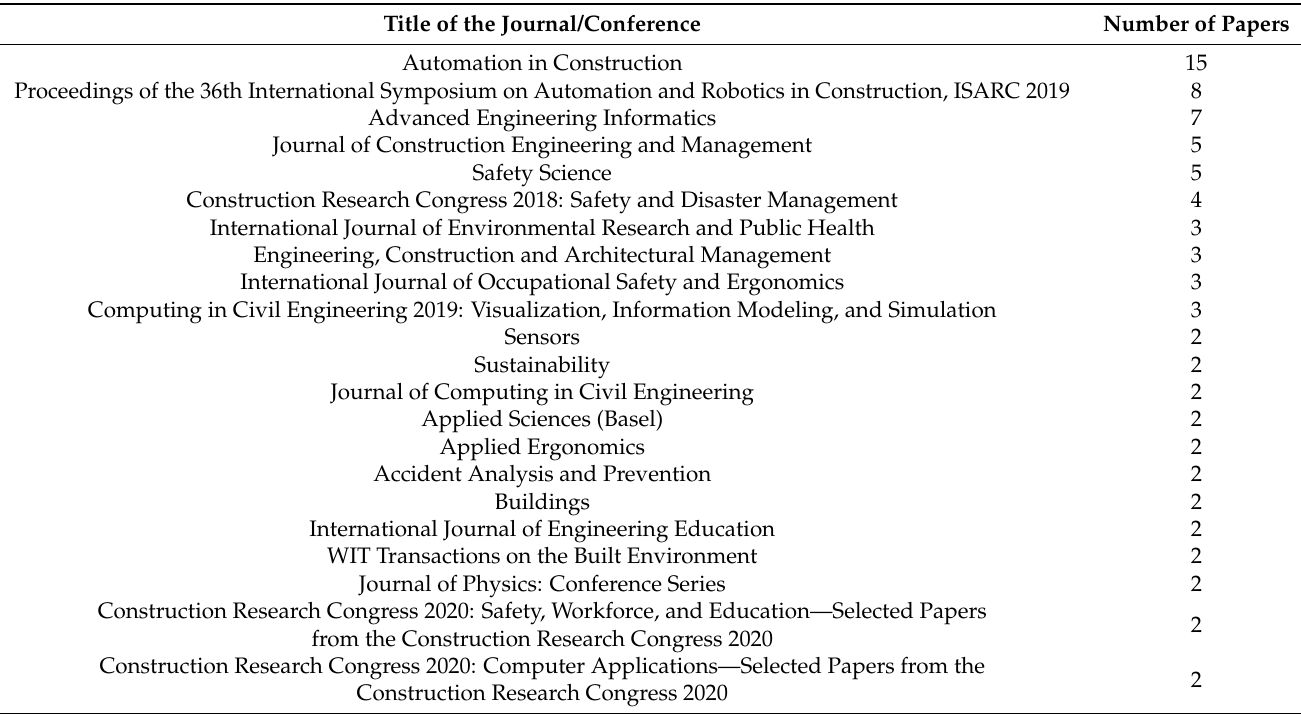
Table 1. Main academic sources identified with two or more articles.